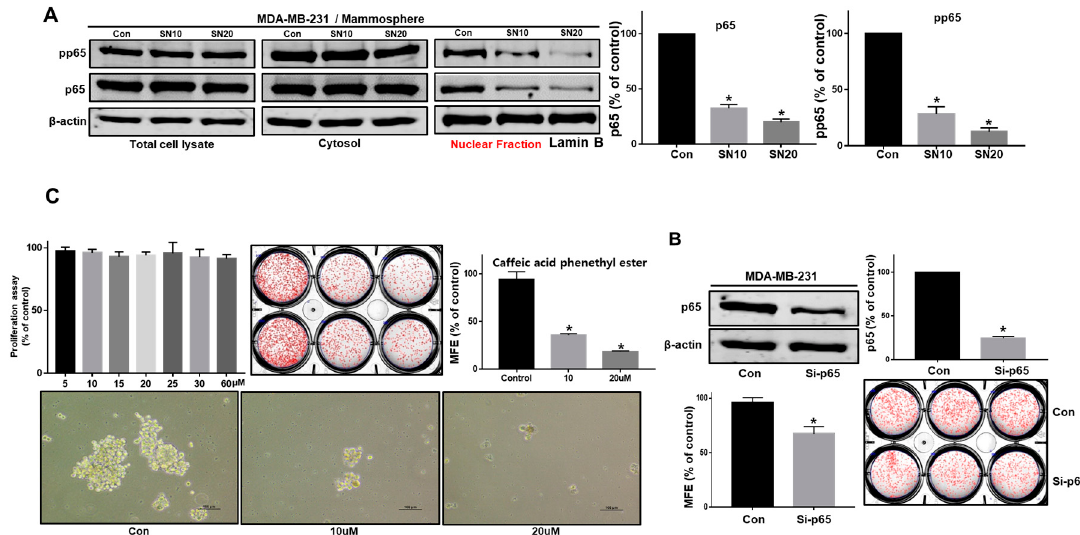
Figure 5. Sulconazole inhibits mammosphere formation through disruption of NF- κ B activity. ( A ) Cancer cells were treated with sulconazole for 24 h. Nuclear and cytosolic proteins were run on a 10% SDS-PAGE gel, followed by immunoblotting with anti-p65 and anti-pp65 antibodies. ( B ) The effect of knocking down p65 expression using a siRNA specific for p65 on mammosphere formation was evaluated. The p65-knockdown effect was confirmed by immunoblotting using an anti-p65 antibody. ( C ) The effect of caffeic acid phenethyl ester, an NF- κ B-specific inhibitor, on mammosphere formation was evaluated. A mammosphere formation assay evaluated mammosphere formation efficiency (MFE) (scale bar = 100 μ m). The data are presented as the mean ± SD; n = 3 independent experiments;* p < 0.05 vs. the control.